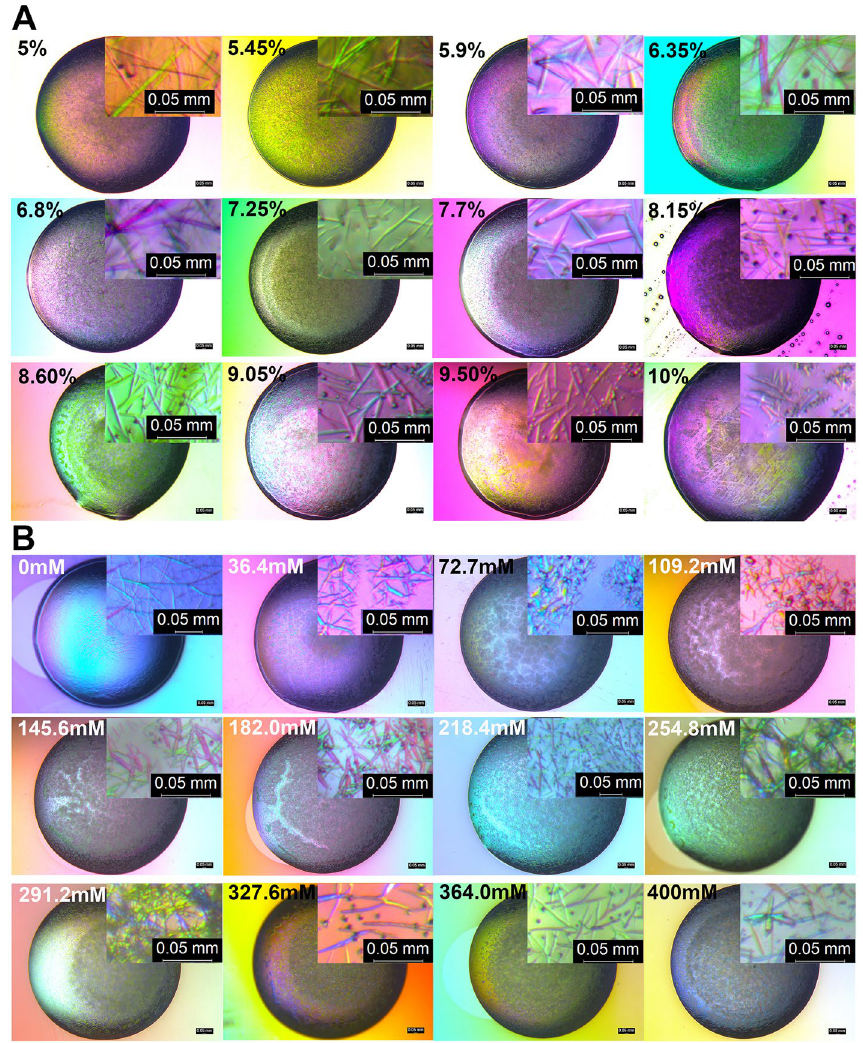
Figure 4. Summary of both PEG 3350 and ammonium sulfate narrow crystallization screening derived from the initial crystallization hits. Shown are visible light images of crystallization drops in 24-well plates using a protein concentration of 1.25 mg/mL. ( A ) Screening of 5–10% PEG 3350. ( B ) Screening of 0–0.4 M ammonium